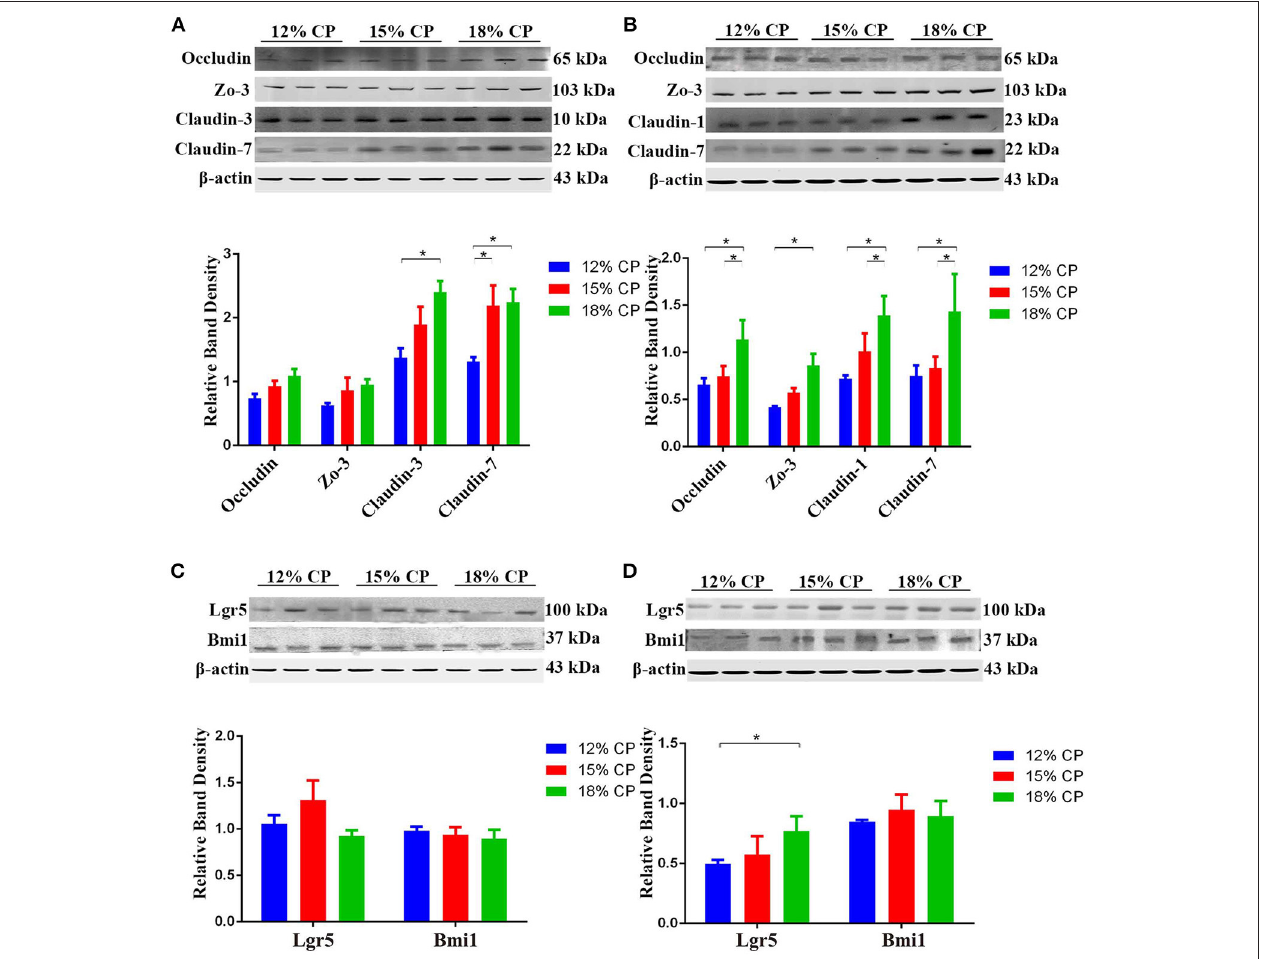
FIGURE 6 | Effects of low-protein diets on the expression of intestinal tight junction proteins and biomarkers of intestinal stem cells of growing pigs. (A) Expression of occludin, ZO-3, claudin-3, and claudin-7 in ileal tissue. (B) Expression of occludin, ZO-3, claudin-1, and claudin-7 in colonic tissue. (C) Expression of Lgr5 and Bmi1 in ileal tissue. (D) Expression of Lgr5 and Bmi1 in colonic tissue. Values are means ± standard deviations ( n = 3). Star indicates a significant difference ( P <